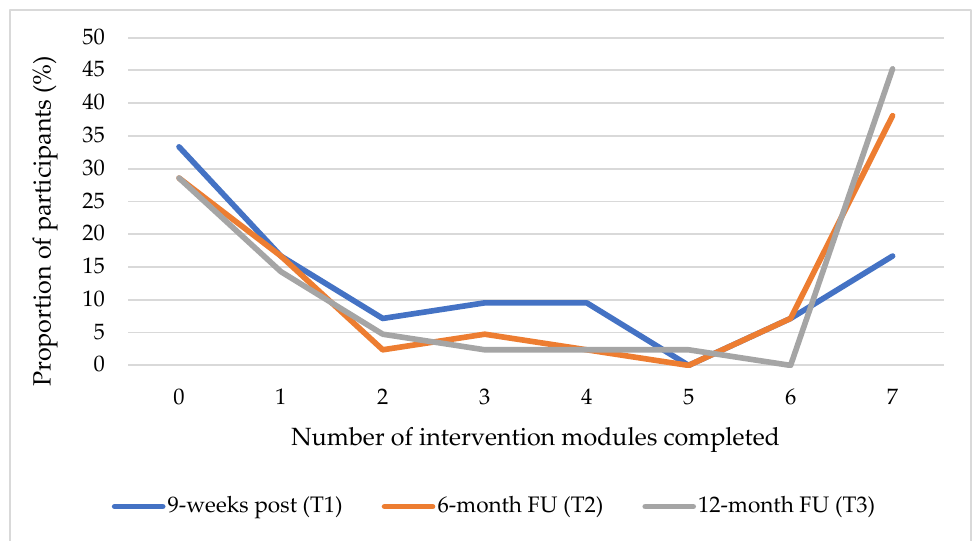
Figure 2. Each curve shows the proportion of participants in IG (N = 42) against the number of completed intervention modules in GET.ON Chronic Pain per measurement point